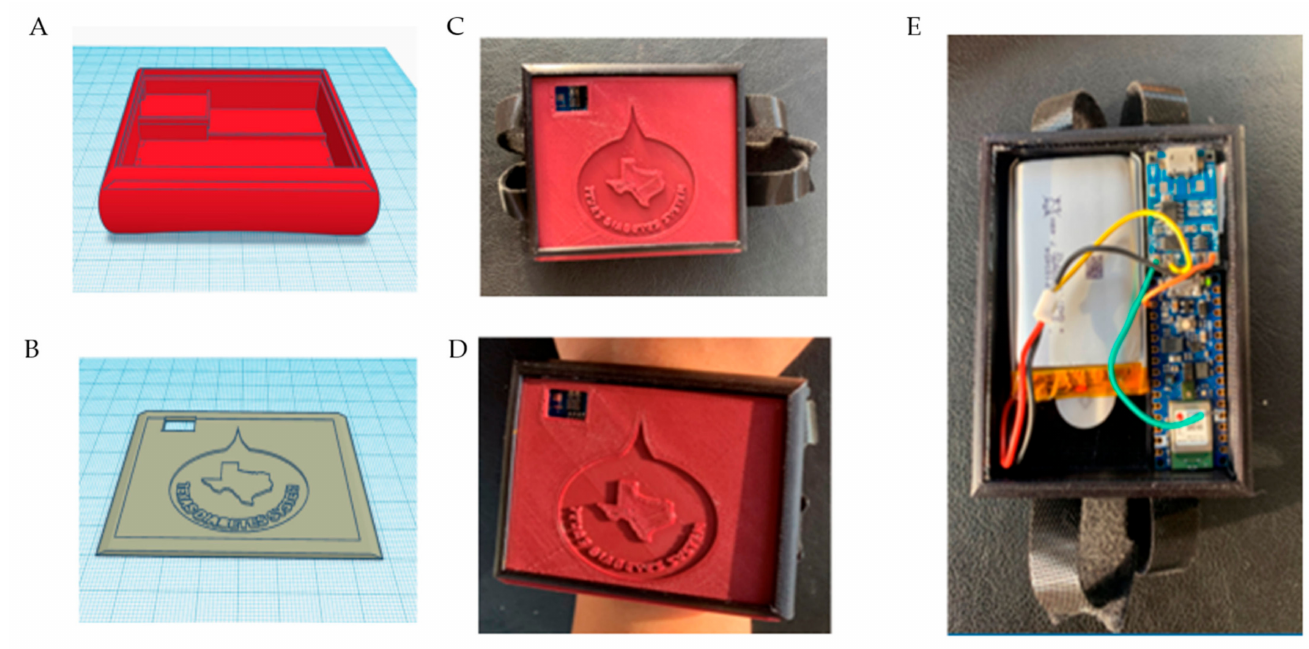
Figure 8. DiAtack wearable band. ( A )—case, ( B )—case cover, ( C )—wearable device, ( D )—wearing the wearable device and ( E )—wearable device with its